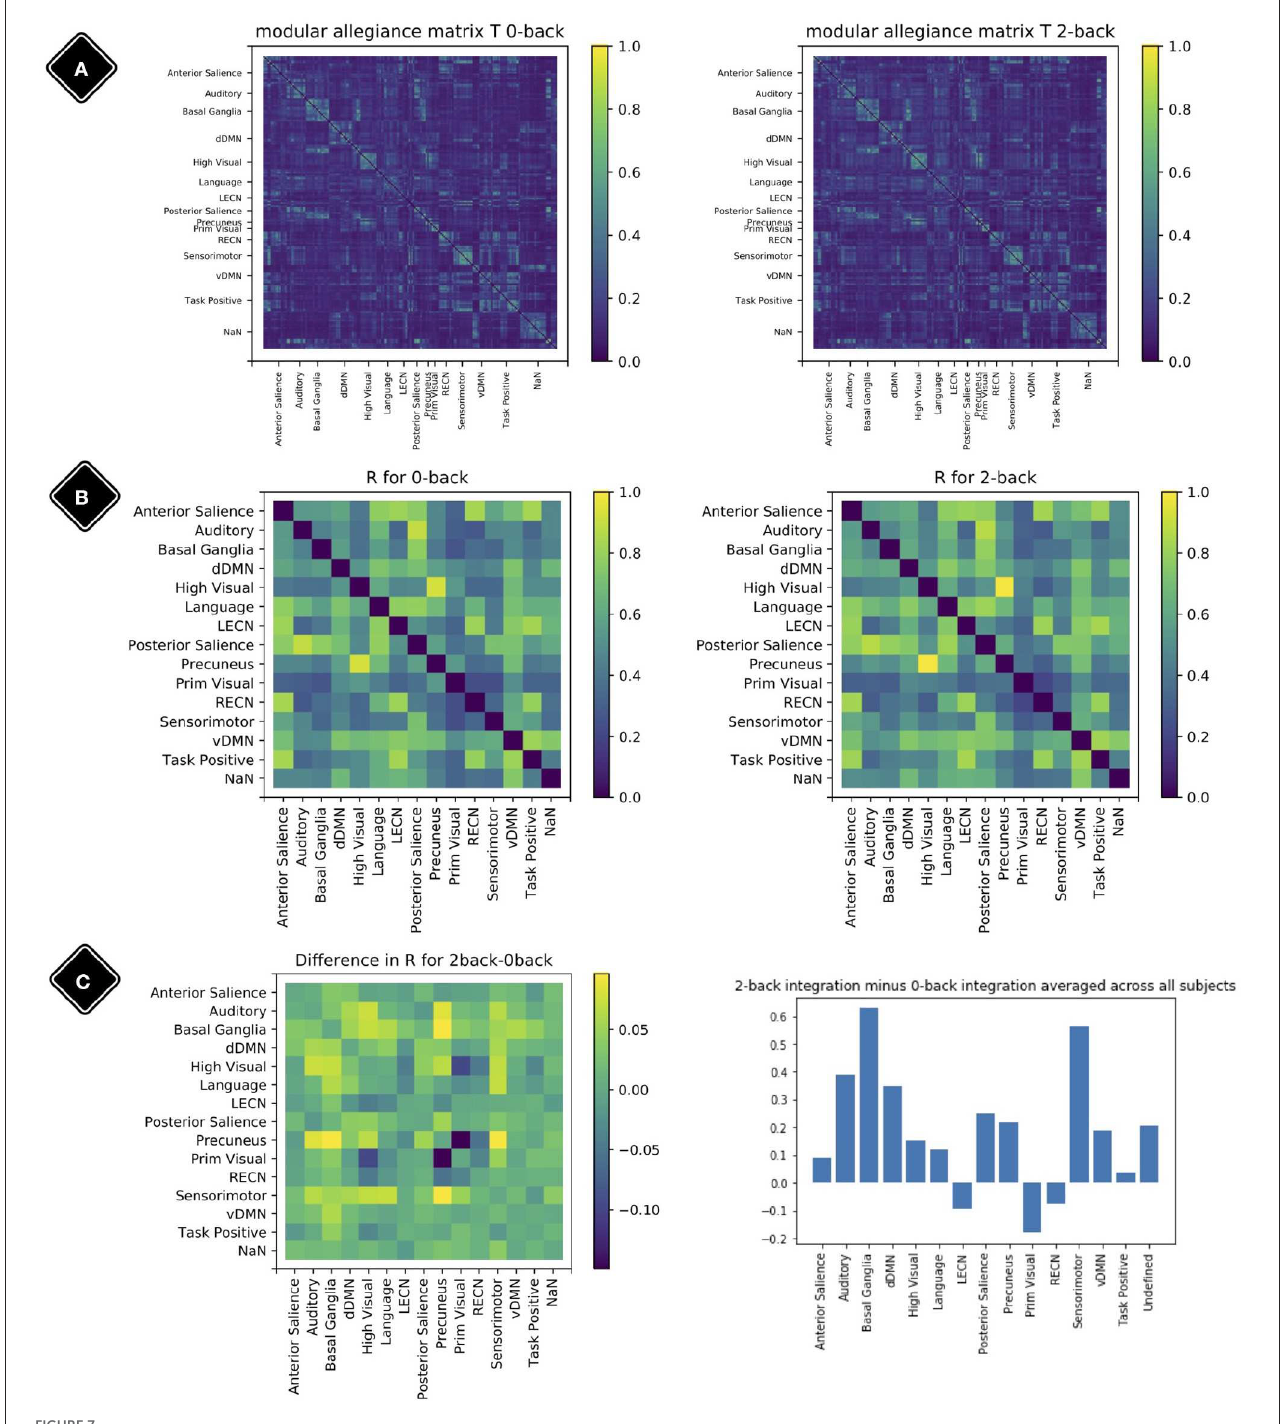
FIGURE7 Modular allegiance and integration. Diagonal elements of the matrices are set to be zero. (A) Modular allegiance of the two conditions 2-back and 0-back; to calculate a T matrix for one condition, we used only the windows with 80% of their time-points in that condition. (B) Integration matrix for 0-back and 2-back. (C) Change in the integration values R 2 − back − R 0 − back (left plot) and sum of rows (from the left plot matrix) as each modules integration value (right